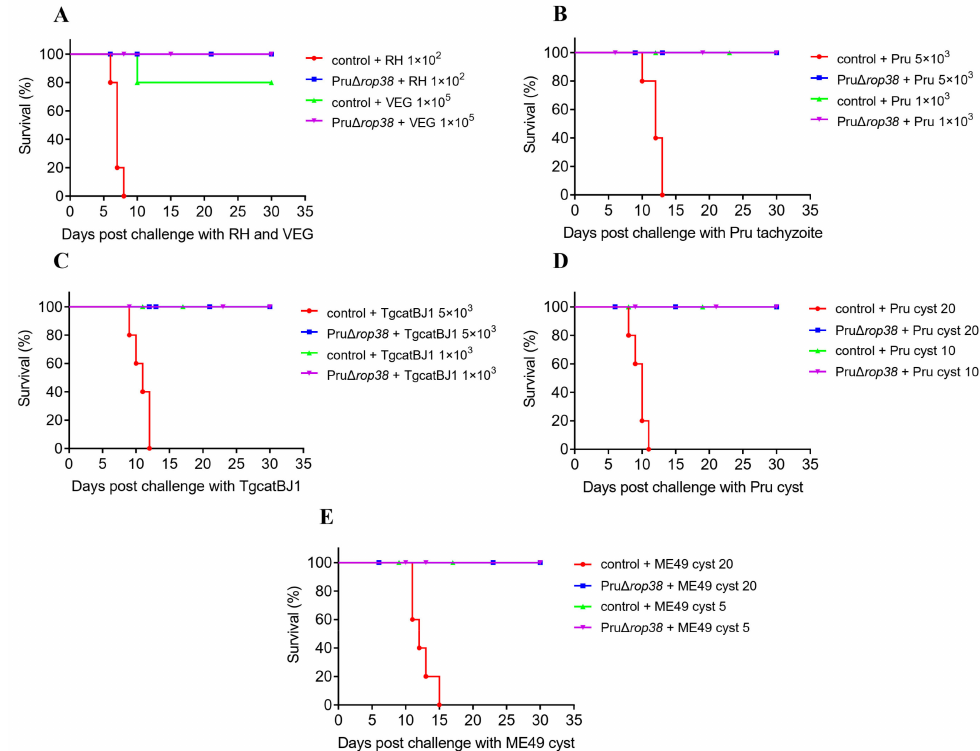
Figure 7. The duration of immunity with Pru ∆ rop38 . Survival rate of vaccinated and control mice re-challenged with ( A ) RH (1 × 10 2 ) and VEG (1 × 10 5 ) tachyzoites, ( B ) Pru (1 × 10 3 and 5 × 10 3 ) tachyzoites, and ( C ) TgCatBj1 (1 × 10 3 and 5 × 10 3 ) tachyzoites, ( D ) Pru (20 and 10) cysts, and ( E ) ME49 (20 and 5) cysts, respectively ( n = 5; mice were injected with tachyzoites intraperitoneally (i.p.) or with cysts orally; daily monitoring of mice for 30